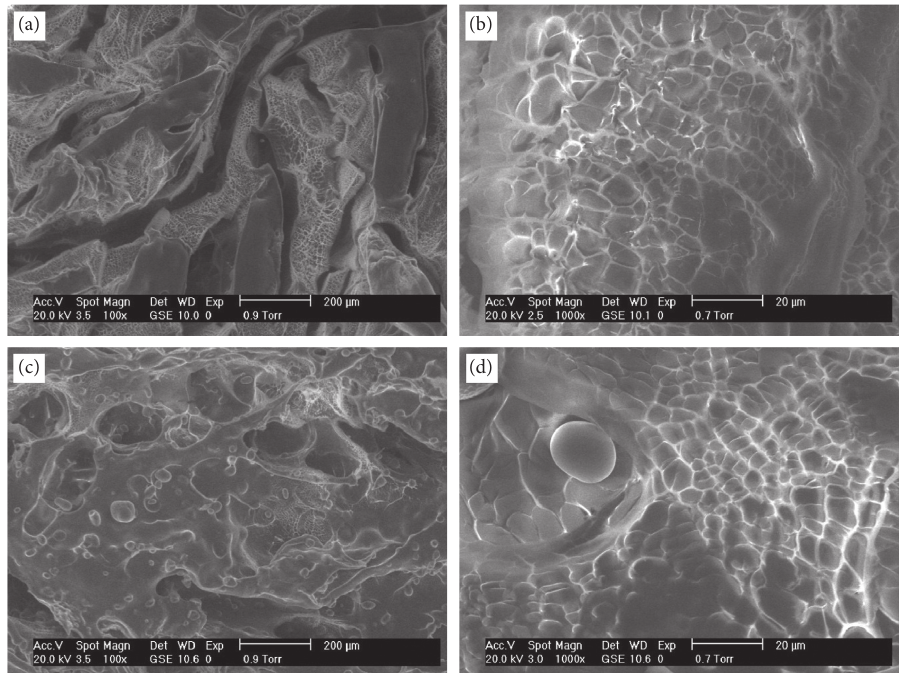
Figure 6: SEM micrographs of cross-sections of PAAm/starch hydrated hydrogels: (a) 100/0 at 200 μ m; (b) 100/0 at 20 μ m; (c) 50/50 at 200 μ m; (d) 50/50 at 20 μ m.